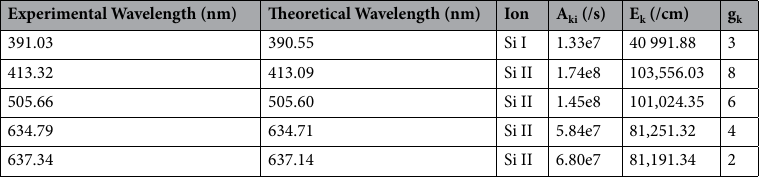
Table 1. Information on the spectral lines.